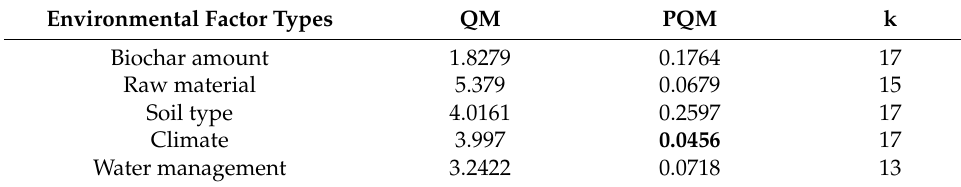
Table 3. Factors affecting CO 2 emissions from paddy soils under biochar